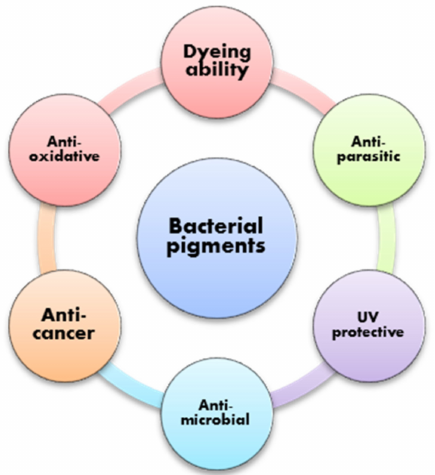
Figure 2. Some of the properties of bacterial pigments that have potential to be transferred to textile materials during